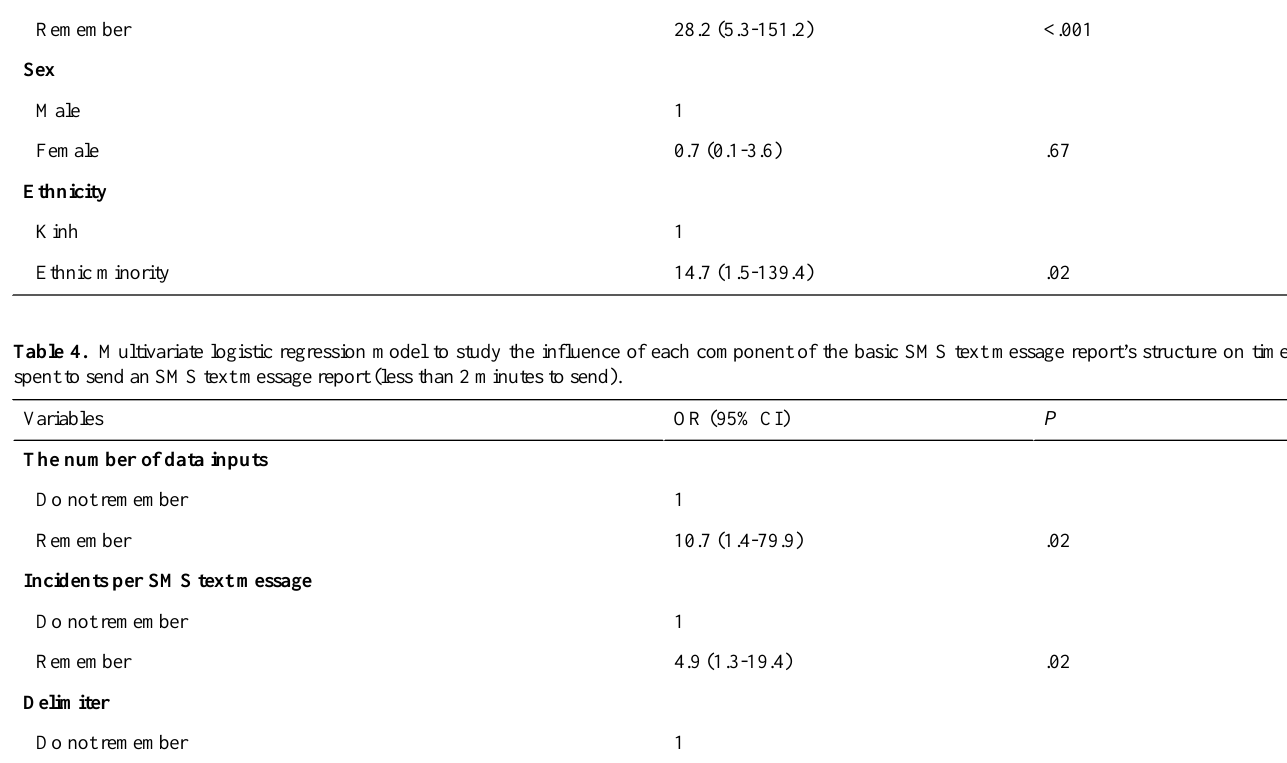
Table 3. Multivariate logistic regression model on the participants’report of taking less time to send SMS text message reports. Basic structure of an SMS text message report